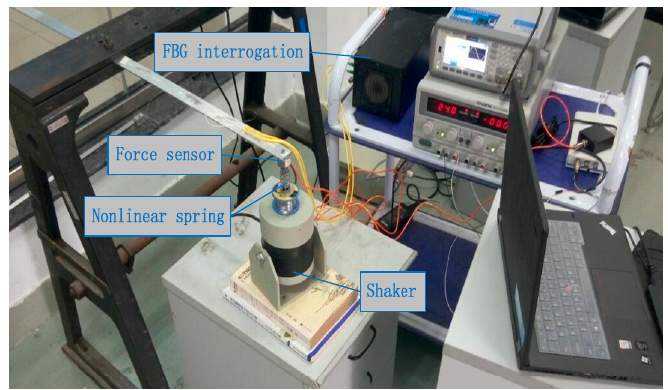
Figure 14. Layout of experiment.